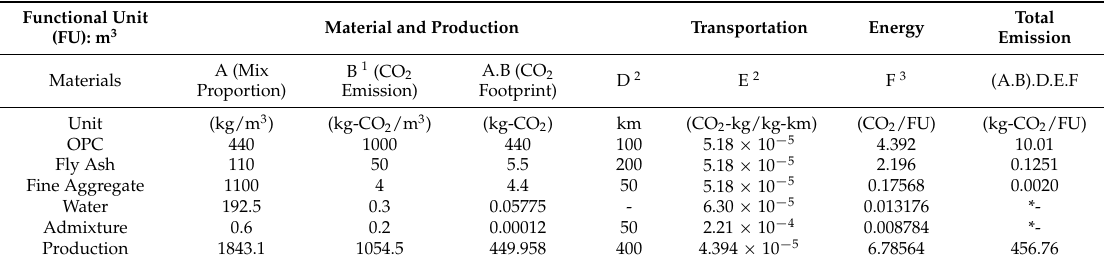
Table 9. Eco-points’ assessment for OPC + 20% fly ash compacting mortar.